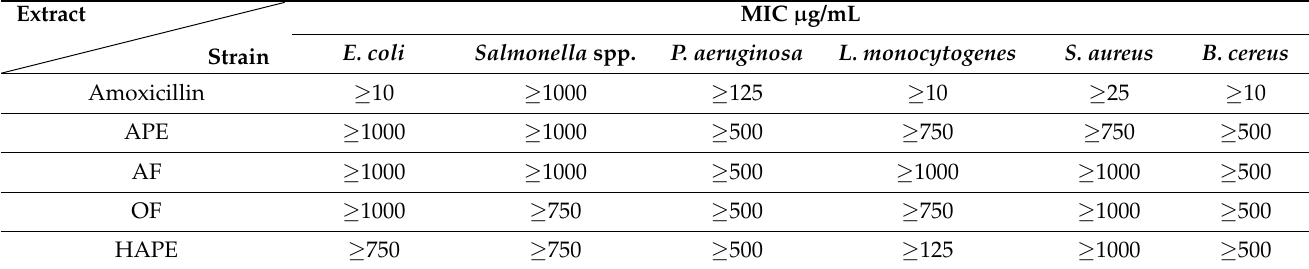
Table 3. Minimal inhibitory concentration (MIC) for avocado peel extract, the fractions, and positive control. Extract